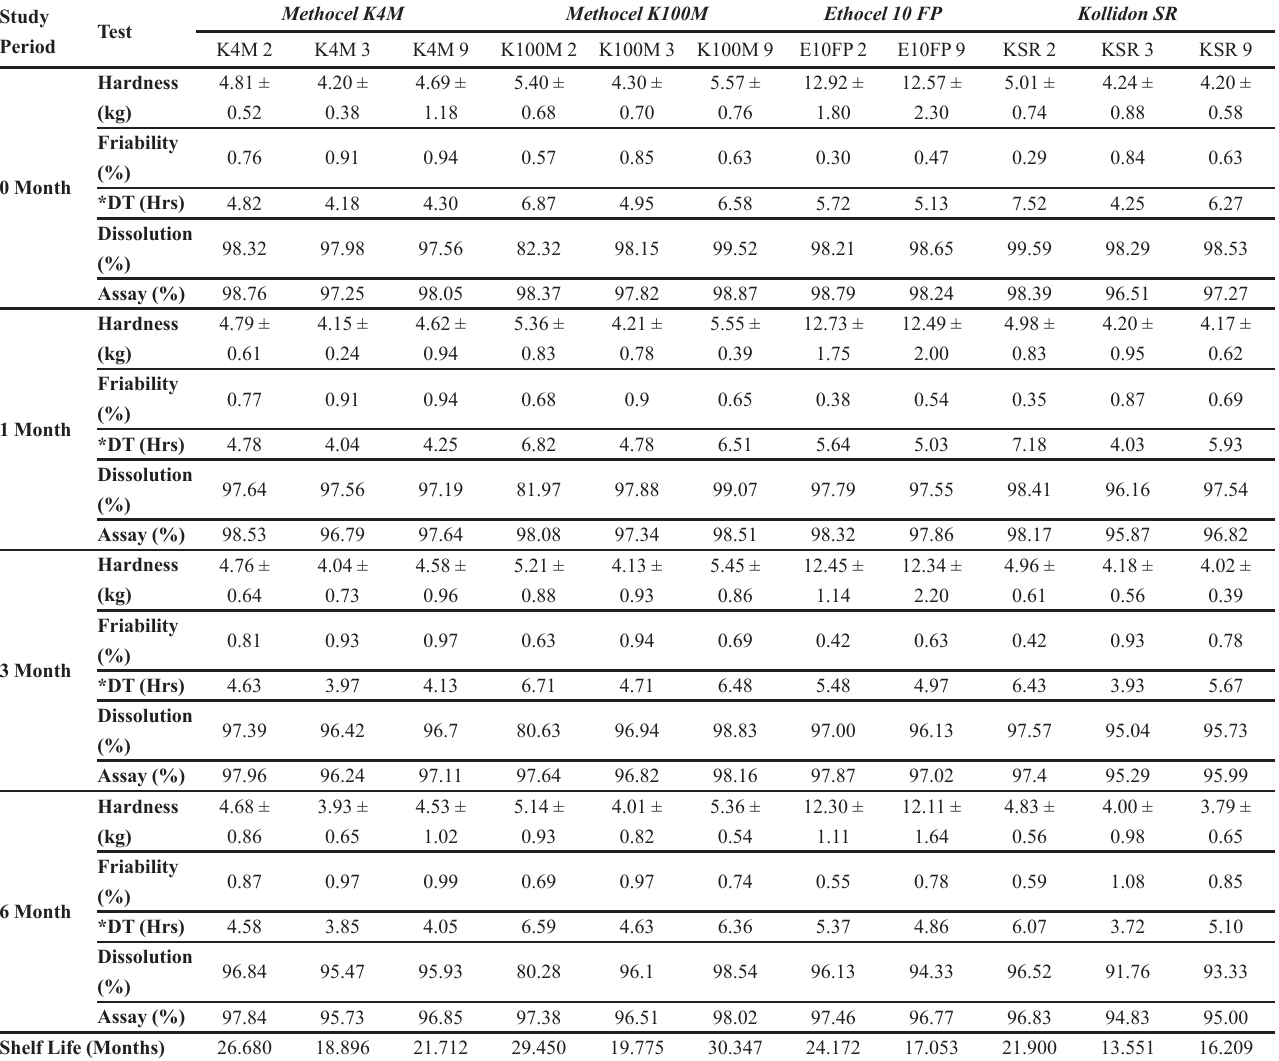
TABLE VI - Stability studies and shelf life of Controlled release tizanidine